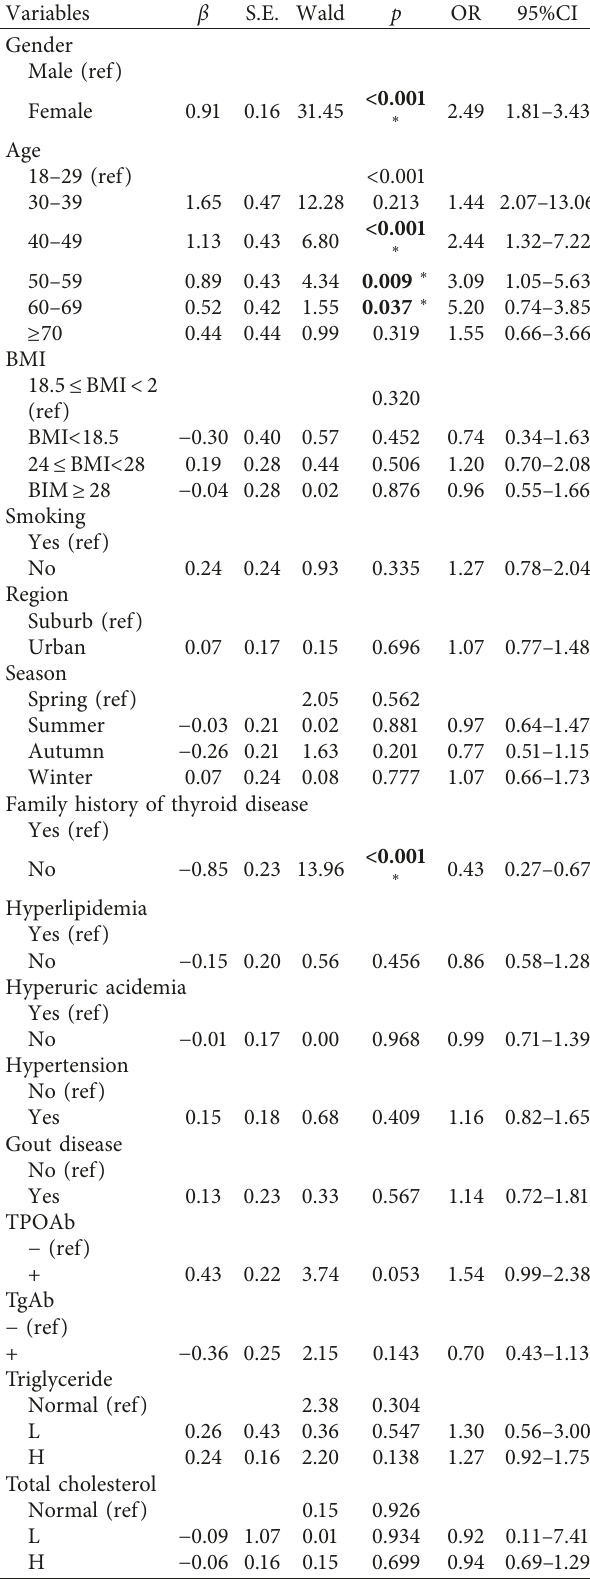
Table 9: Multivariate logistic regression analysis of the prevalence of thyroid